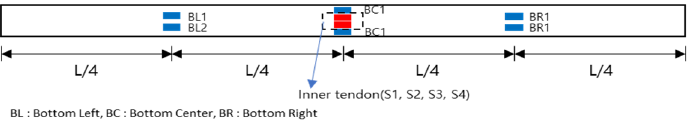
Figure 7. Lower concrete and inner tendon gauge positions (NSM and EP